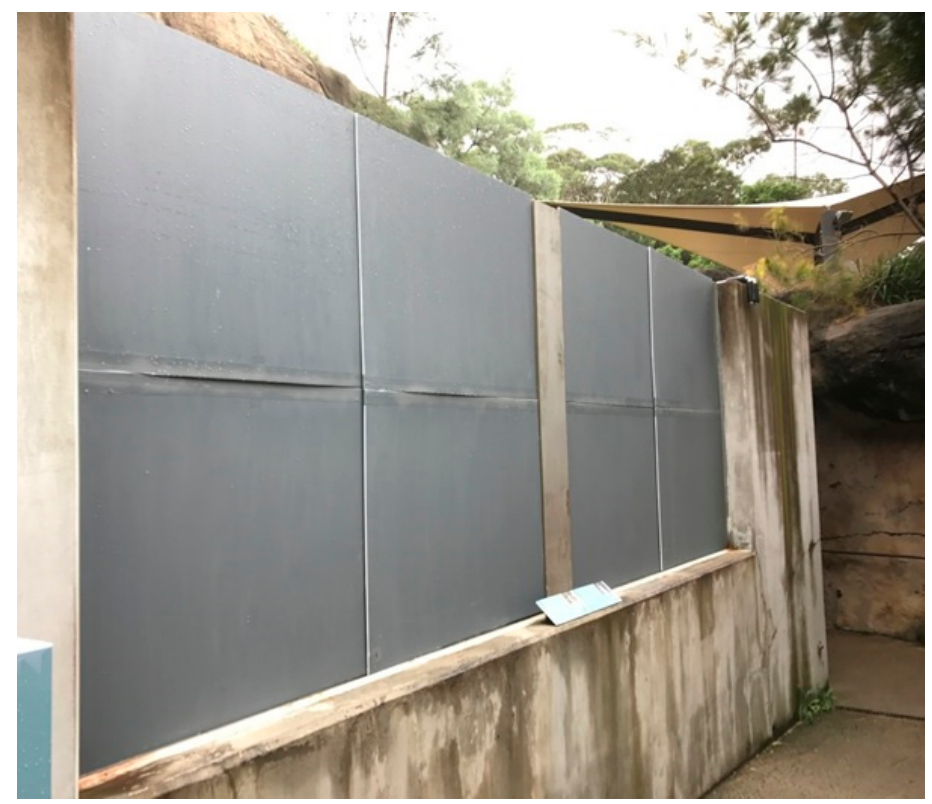
Figure 3. The visual barrier used to block contact between visitors and penguins at the main visitor viewing area window.